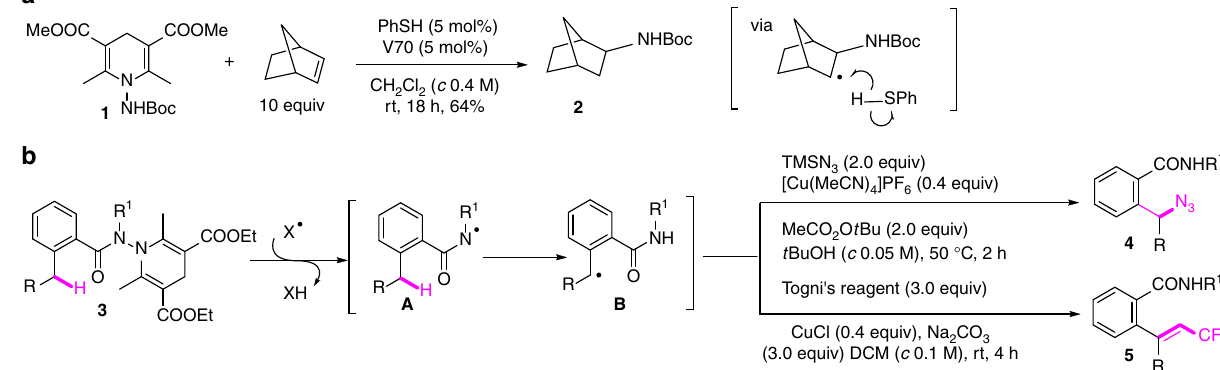
Fig. 1 Amidyl radicals and HLF reaction. a Studer ’ s work on the use of N -aminated dihydropyridines as precursors of N -centered radicals: hydroamination of alkenes; b benzohydrazides in HLF reaction: functionalization of remote C( sp 3 ) – H bond. V70 = 2,2 ’ -azobis(2,4-dimethyl-4-methoxy valeronitrile); TMSN 3 = trimethylsilyl azide; MeCO t Bu = tert -butyl 2 O